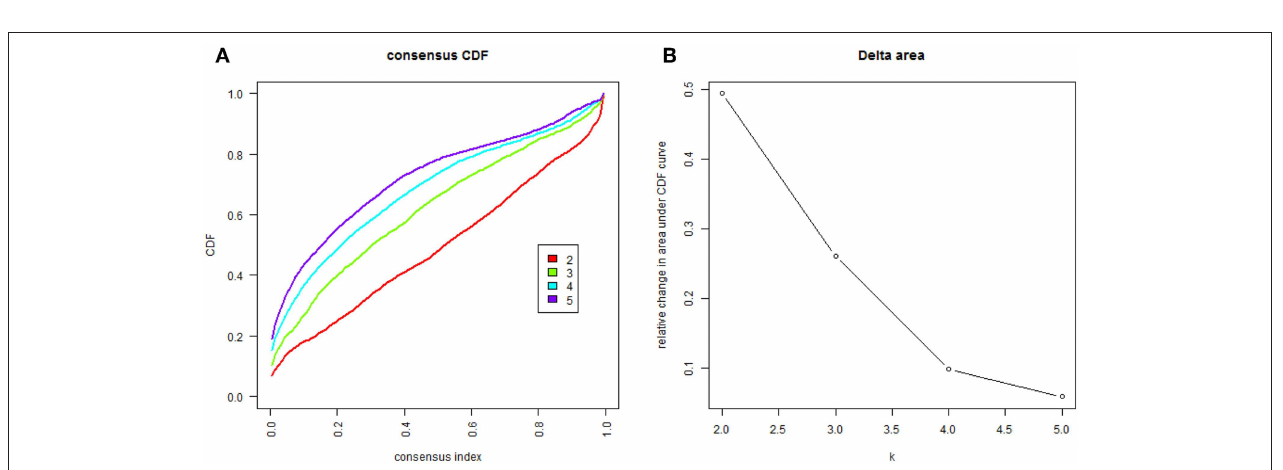
FIGURE 11 | The cluster counts evaluated. (A) CDF curve of K = 2–7. (B) The relative change in area under the CDF curve of K = 2–7.